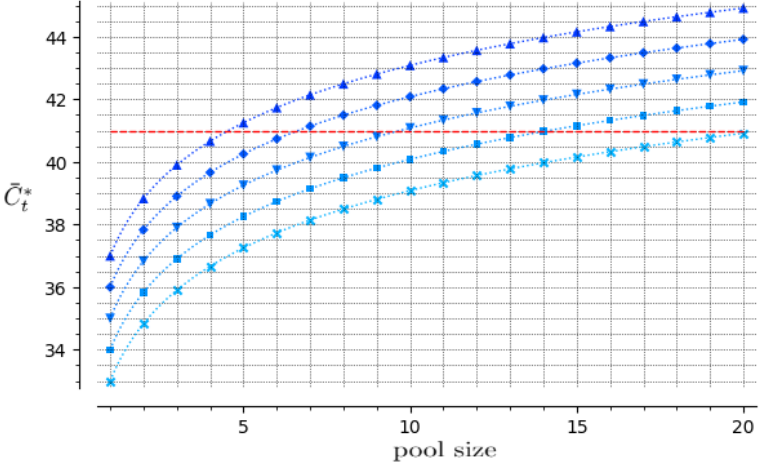
∗ Figure 1. Cut-off values, (cid:1829)̅ (cid:3047)∗ , that are to be employed in pool testing, as a function of pool size N , for Figure 1. Cut-off values, C t , that are to be employed in pool testing, as a function of pool size N , for individual test cut-off values (cid:1829)̅ (cid:3047) = 33 (x), (cid:1829)̅ (cid:3047) = 34 ( ■ ), (cid:1829)̅ (cid:3047) = 35 ( ▼ ), (cid:1829)̅ (cid:3047) = 36 ( ♦ ), and (cid:1829)̅ (cid:3047) = 37 individual test cut-off values C t = 33 (x), C t = 34 ( (cid:4) ), C t = 35 ( (cid:72) ), C t = 36 ( (cid:7) ), and C t = 37 ( (cid:78) ). The ( ▲ ). The maximal possible value for the adjusted cut-off in pool processing, (cid:1829)̅ (cid:3047)∗ = 41 , is represented maximal possible value for the adjusted cut-off in pool processing, C by the horizontal dashed line. The maximum pool sizes are (cid:1840) = 4 , for (cid:1829) ̅ (cid:3047) = 37 , and (cid:1840) = 20 , for (cid:1829)̅ (cid:3047)∗ < 41 . (cid:1829)̅ horizontal dashed line. The maximum pool sizes are N = 4, for C t = 37, and N = 20, for C t = 33, (cid:3047) = 33 , both allowing ∗ < both allowing C t